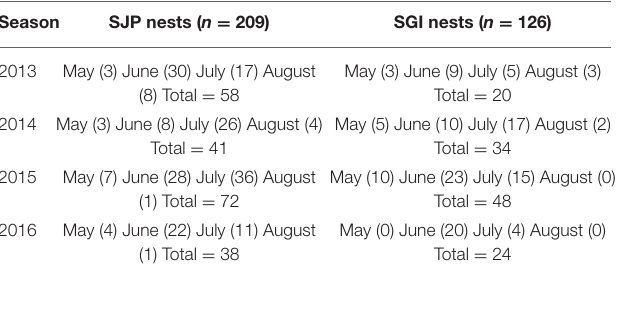
TABLE 1 | Loggerhead sea turtle nest data from SJP and SGI considered in this study ( n = 335) from 2013 to 2016, the number of nests considered is indicated in parenthesis.